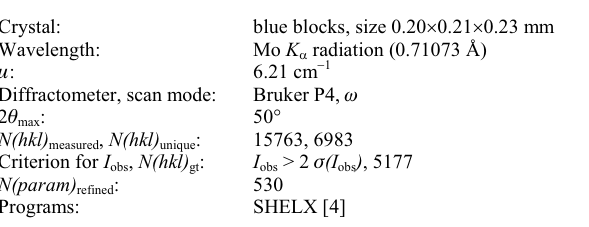
Table 1. Data collection and handling.